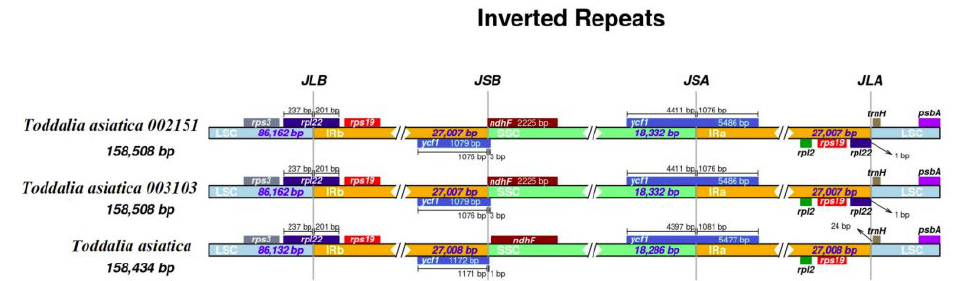
Figure 3. Comparison of the borders of large single copy (LSC), small single copy, (SSC), and inverted repeat (IR) regions among the Toddalia plastomes. Different color boxes indicate specific genes.